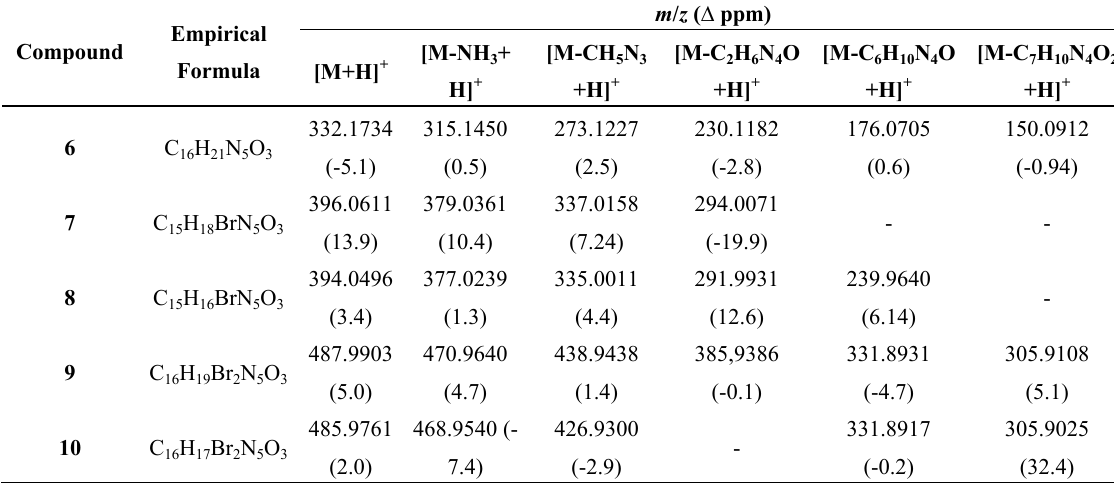
Table 2. Pseudo-molecular ions and characteristic fragments observed in ESI-(+) of compounds 6 - 10 .